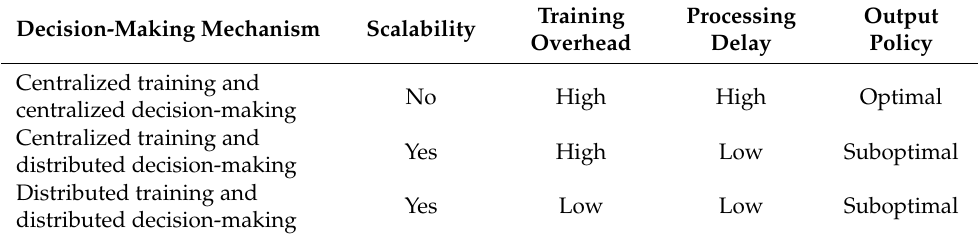
Table 4. The differences of the centralized and distributed